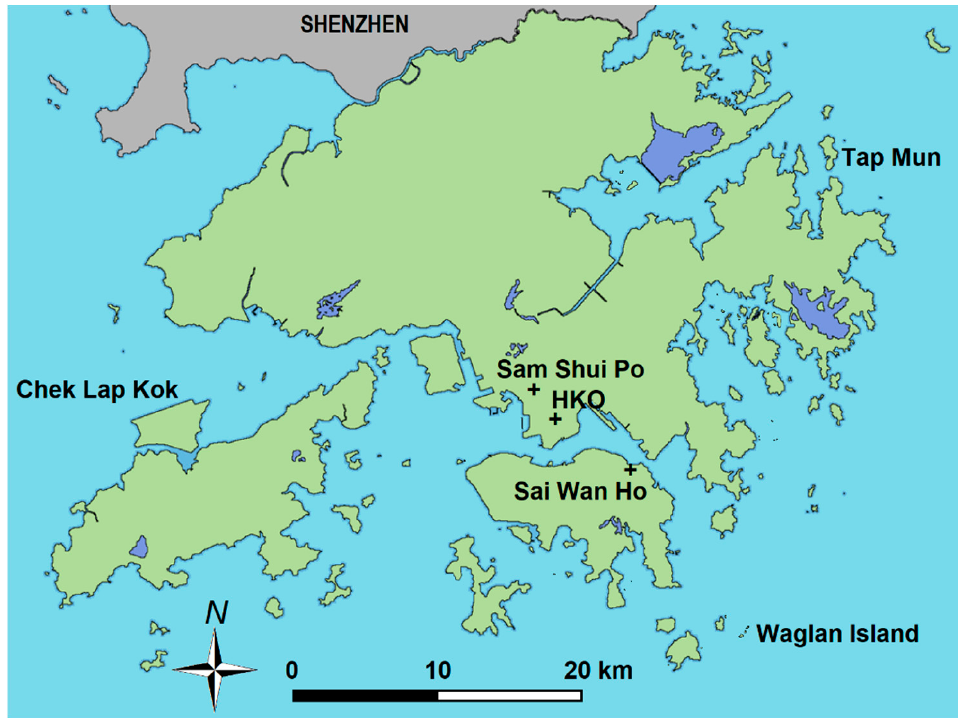
Figure 1. Map of Hong Kong showing locations mentioned in the text. Mong Kok, although not displayed, lies midway between HKO and Sam Shui Po.